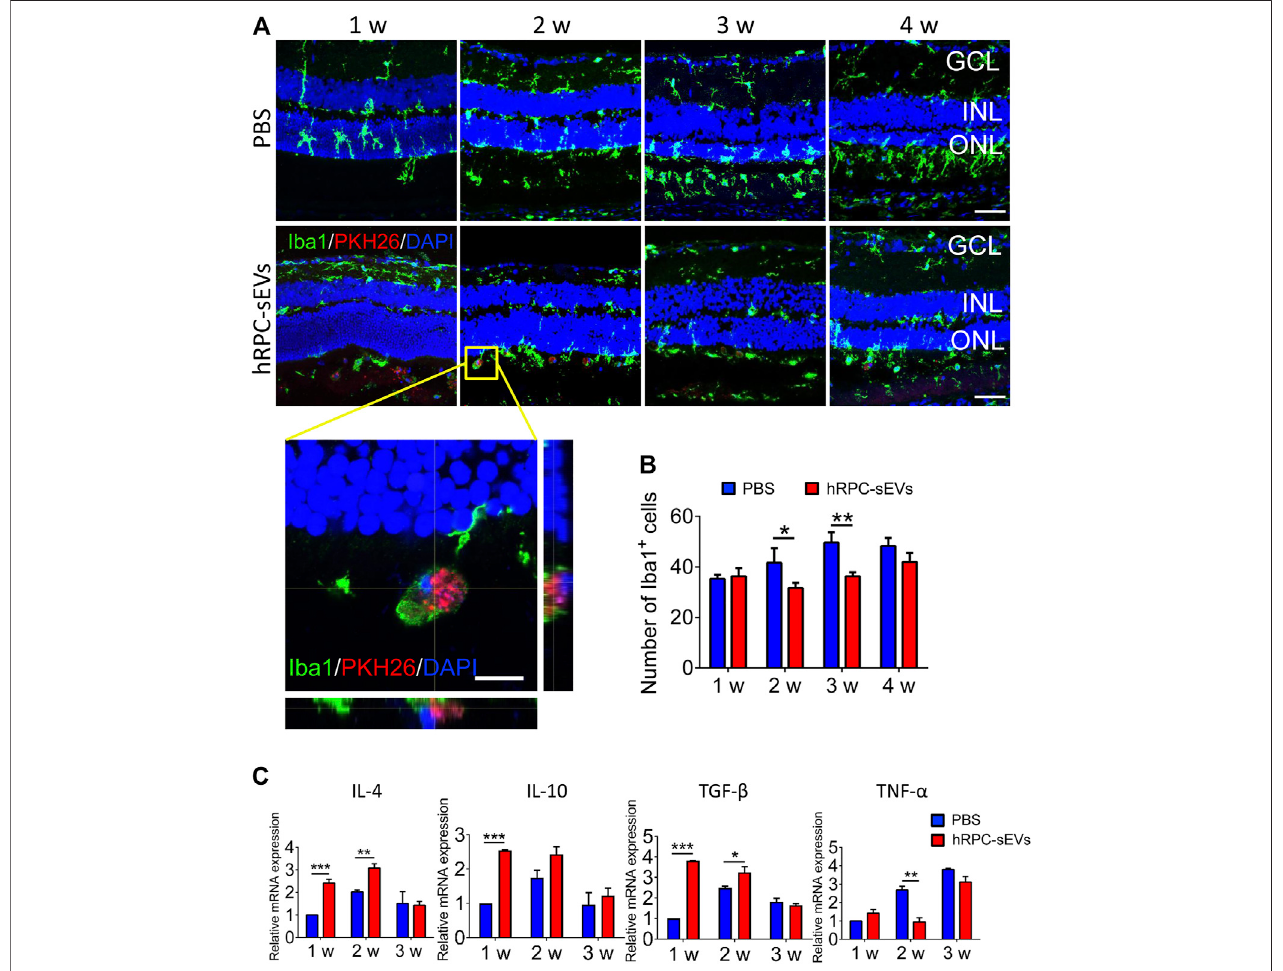
FIGURE 4 | hRPC-sEVs suppress the activation of microglia and regulate cytokines in the retina of RCS rats. (A) Iba1 (green) staining of PBS-treated (top panel) and hRPC-sEV – treated (bottom panel) RCS retinas at different time after transplantation. hRPC-sEVs are labeled by PKH26 (red). Enlarged orthogonal view of hRPC- sEVsattheinjectedsiteshowsthattheEVsareco-locatedwithmicrogliainsubretinalspace(SRS). (B) Thenumber ofIba1-positive cellsintheinjected areaoftheretina isanalyzed andcomparedinhRPC-sEV – andPBS-treatedgroupsatdifferenttimepoints(n (cid:2) 3pergroup). (C) RelativemRNAlevelsofcytokinesIL-4,IL-10,TGF- β , and TNF- α in the retinas (n (cid:2) 3 per group). Data are shown as means ± SD. * p < 0.05, ** p < 0.01, and *** p <